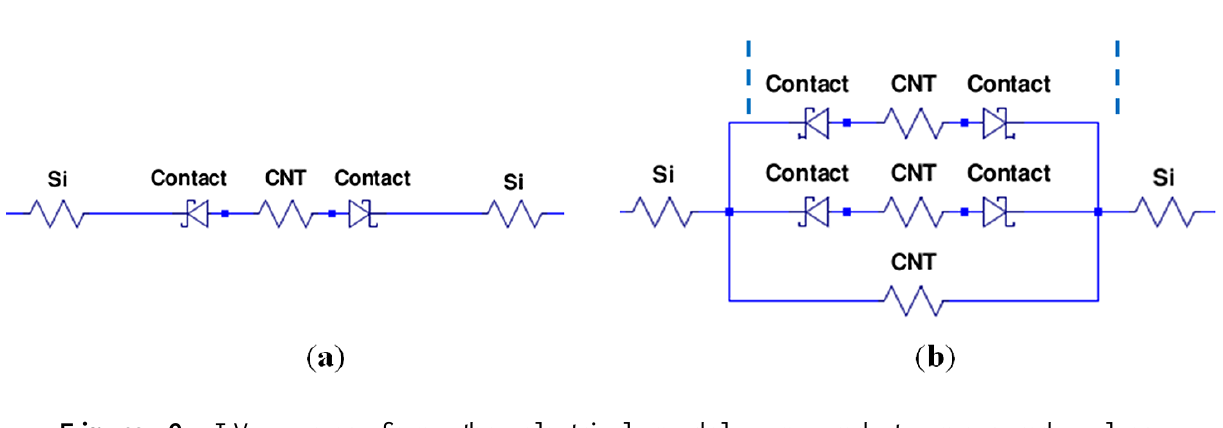
Figure 8. Electrical model representing the Si/CNT/Si system yielding ( a ) rectifying characteristics; and ( b ) near-ohmic characteristics.